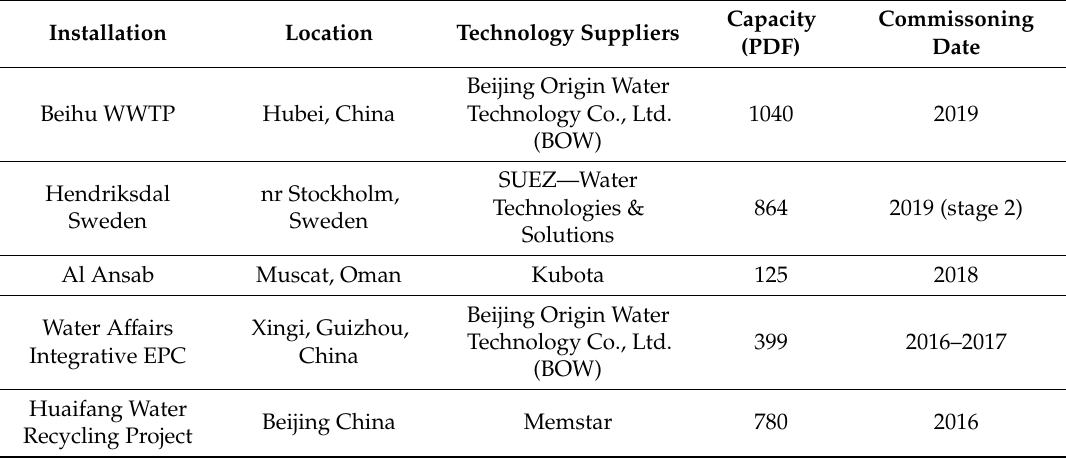
Table 3. Most recent large-scale MBR plants worldwide [125].